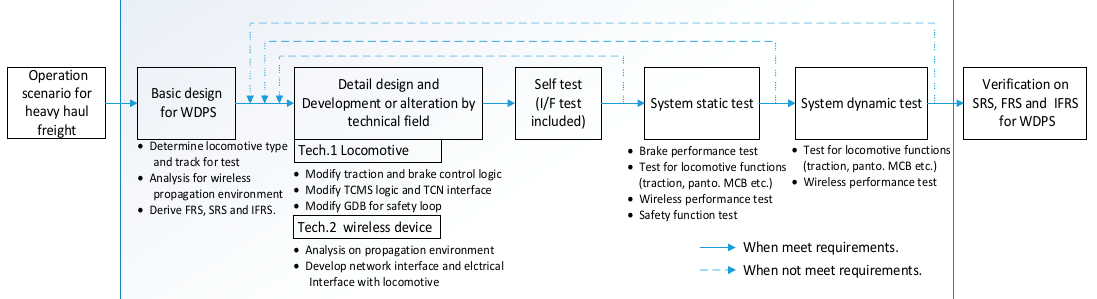
Figure 1. WDPS development methodology.